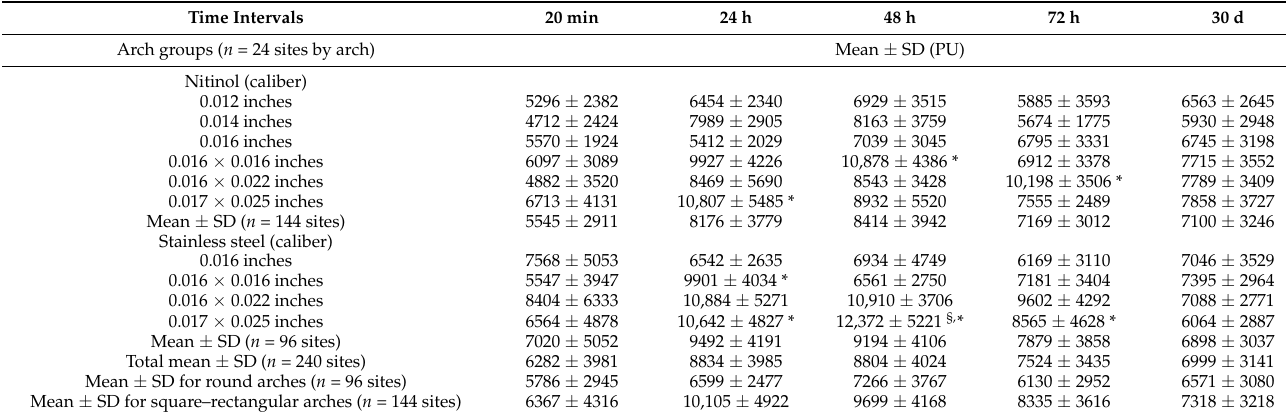
Table 1. Evaluation of the integrated primary basal flow (IPBF) in patients with orthodontic treatment (Nitinol and steel arches) at different time